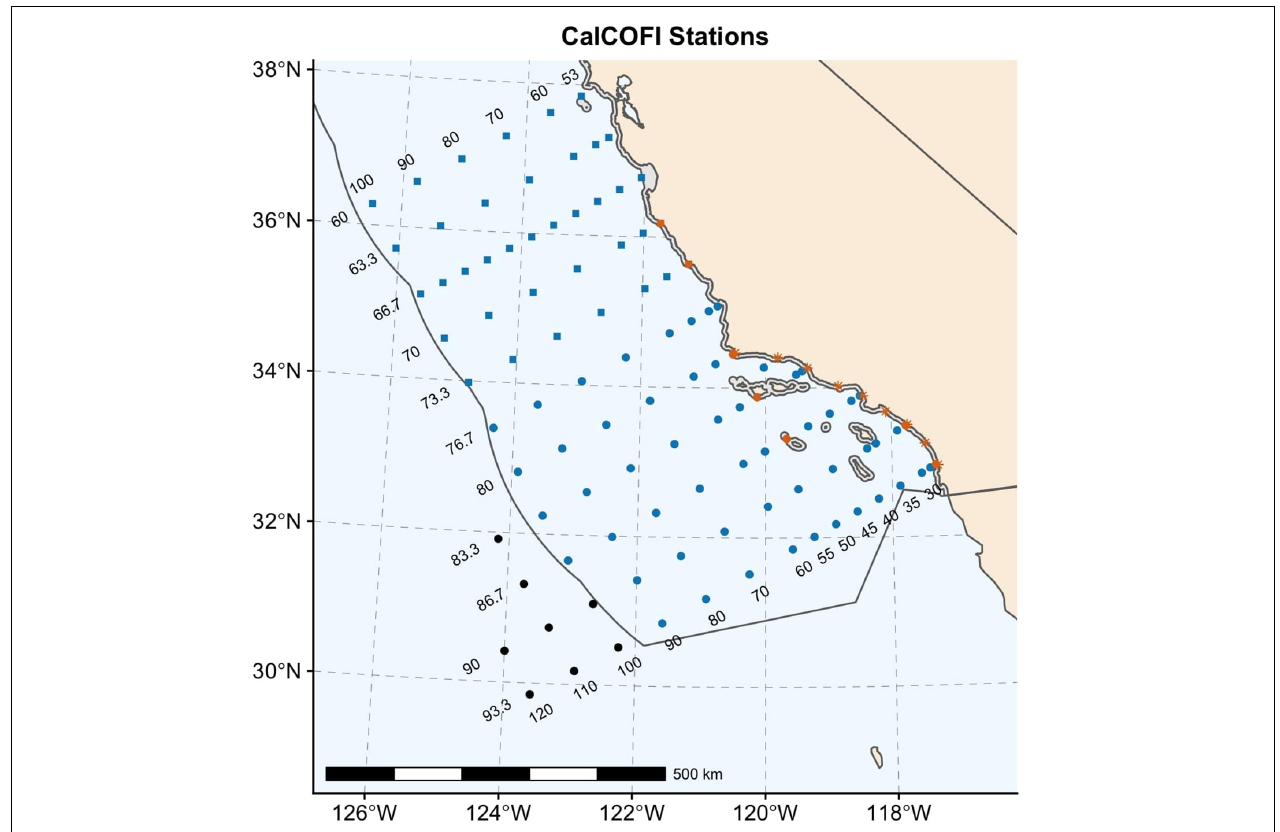
FIGURE 1 | Map of 113 CalCOFI stations as relates to U.S. jurisdictional boundaries. In CalCOFI stations are shown based on if they occur in state (orange), federal (blue), or international (black) waters. The US exclusive economic zone is shown with a black outline and California state waters are shown in gray surrounding land (tan). Circles represent the 66 station “core grid,” squares represent the 38 extended grid stations, and the 9 nearshore stations are represented with asterisks. CalCOFI lines (horizontal) and stations (vertical) are indicated by the labels on the left of the grid and at the top and bottom of the grid, respectively. Not all station labels are shown. A scale bar is provided for spatial